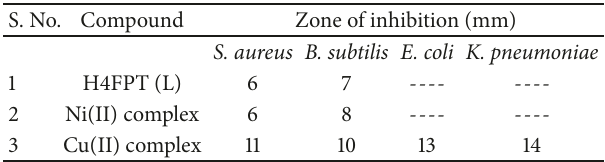
Table 5: Antibacterial activity of H4FPT and its complexes. S. No. Compound Zone of inhibition